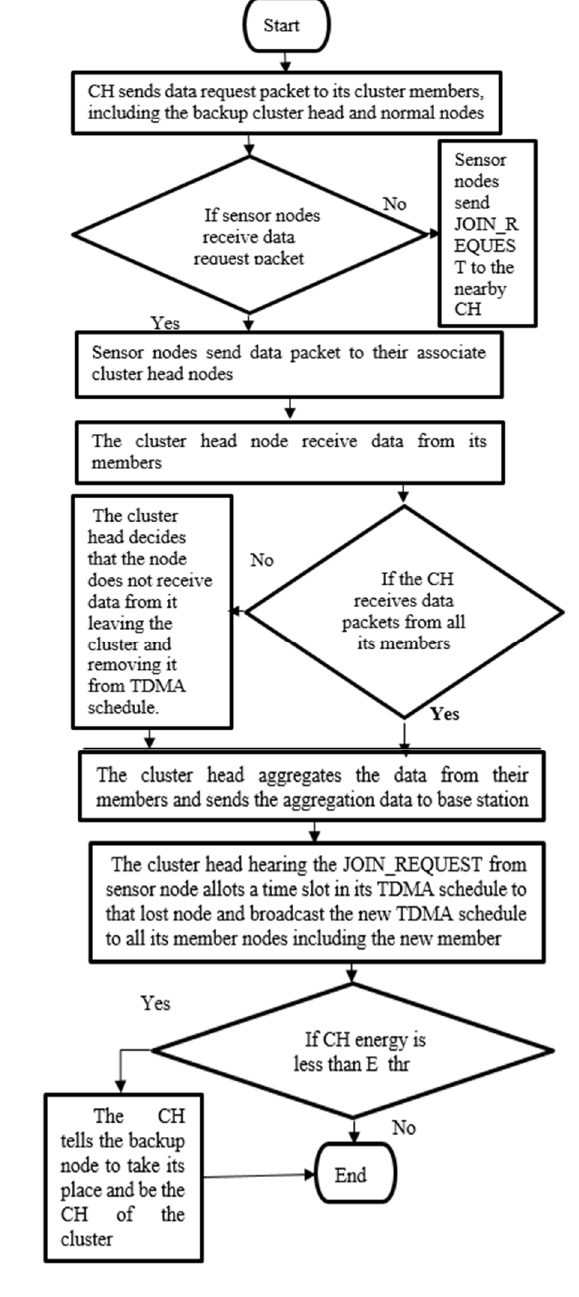
Fig. 9. Flowchart of One Frame of Steady-State Phase